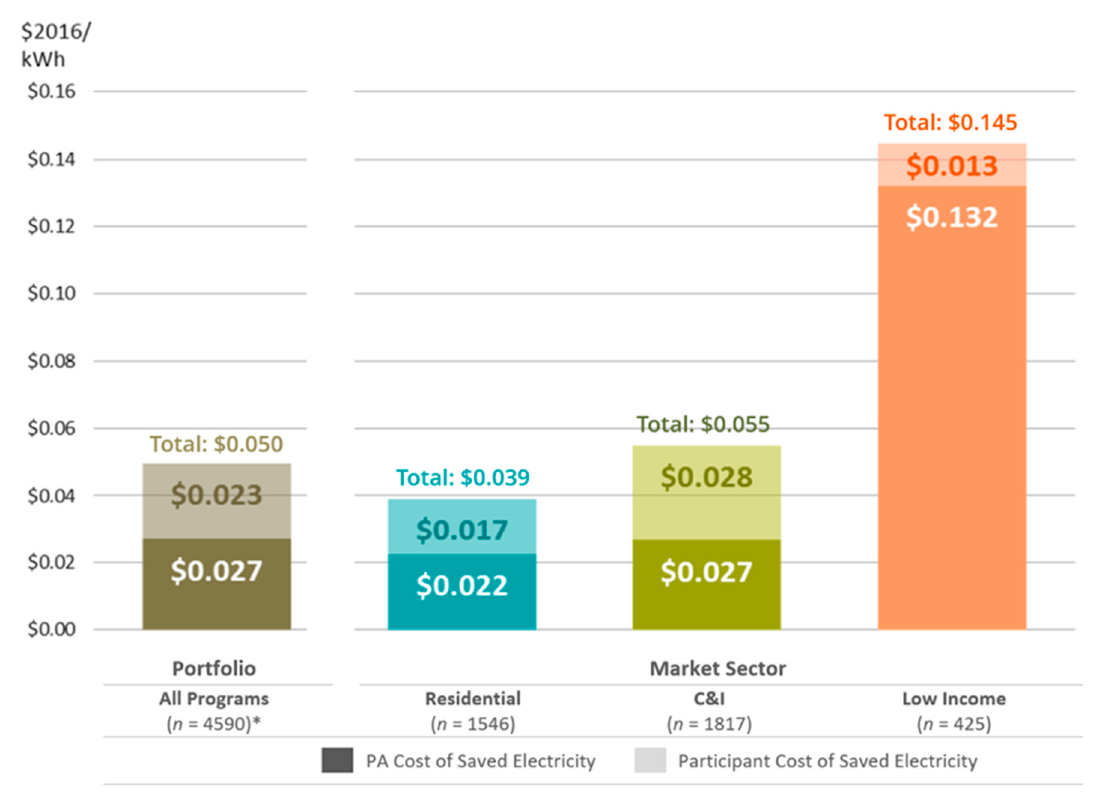
Figure 7. Total CSE for electricity e ffi ciency programs by sector: national savings-weighted averages. * Note: The sample size for the total CSE is smaller than for the program administrator CSE because program administrators in only 27 states reported information on participant costs.